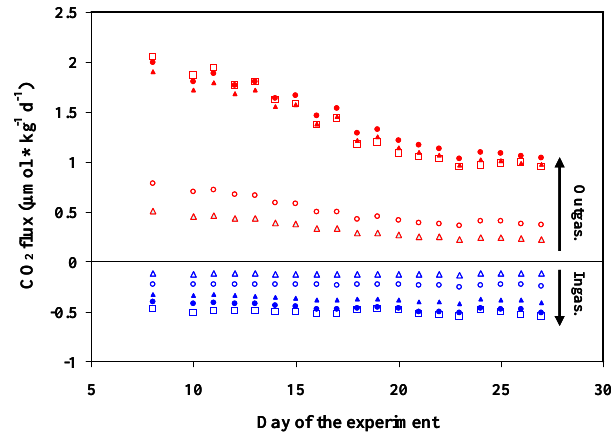
907 Fig. 7. Comparison of different approaches to estimate CO 2 air– Fig. 7 908 sea gas exchange. Daily ingassing rates in the low CO 2 control Comparison of different approaches to estimate CO 2 air-sea gas exchange. Daily ingassing 909 treatment (average ∼ 180µatm) are shown in blue, while outgassing rates in the low CO 2 control treatment (average ~180µatm) are shown in blue, while 910 from the highest CO 2 treatment (average ∼ 1085µatm) is red. Filled outgassing from the highest CO 2 treatment (average ~1085µatm) is red. Filled symbols are 911 symbols are estimates from the N 2 O tracer approach, circles ( • ) estimates from the N 2 O tracer approach, circles for chemical enhanced flux ( / ) and 912 for chemical enhanced flux and triangles ( N ) for non chemical en- triangles ( / ) for non chemical enhanced flux. Open squares ( / ) are an estimate using a 913 hanced flux. Open squares ( (cid:3) ) are an estimate using a quadratic quadratic wind dependent function according to Wanninkhof (1992) at a constant wind speed 914 wind dependent function according to Wanninkhof (1992) at a con- of 3.15 m s -1 , chosen to match the N 2 O results. Open circles ( / ) is a chemically enhanced 915 stant wind speed of 3.15ms − 1 , chosen to match the N 2 O results. zero wind speed output, according to Smith (1985), while open triangles ( / ) are the same 916 Open circles ( ◦ ) are a chemically enhanced zero wind speed output, estimate without chemical enhancement. 917 according to Smith (1985), while open triangles ( 4 ) are the same estimate without chemical